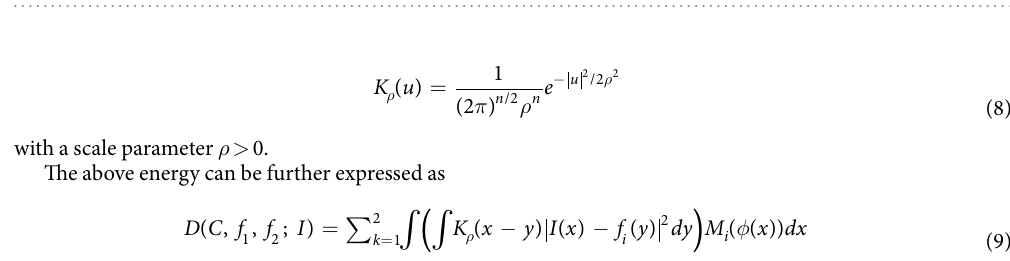
Table 1. The parameters used in all experiments.